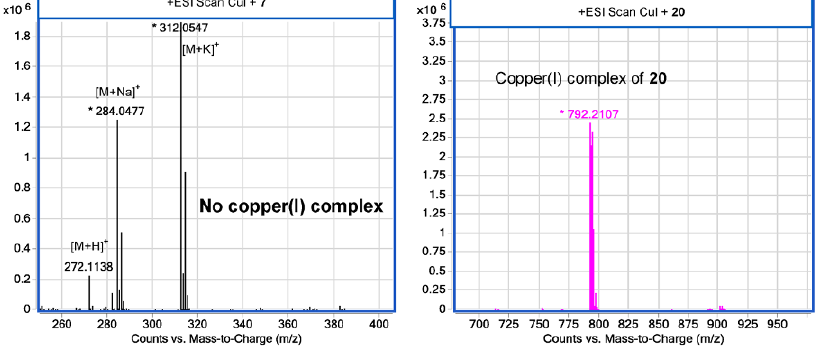
Figure 2. HRMS spectrum of 7 with CuI (left) and 20 with CuI (right). Only the C